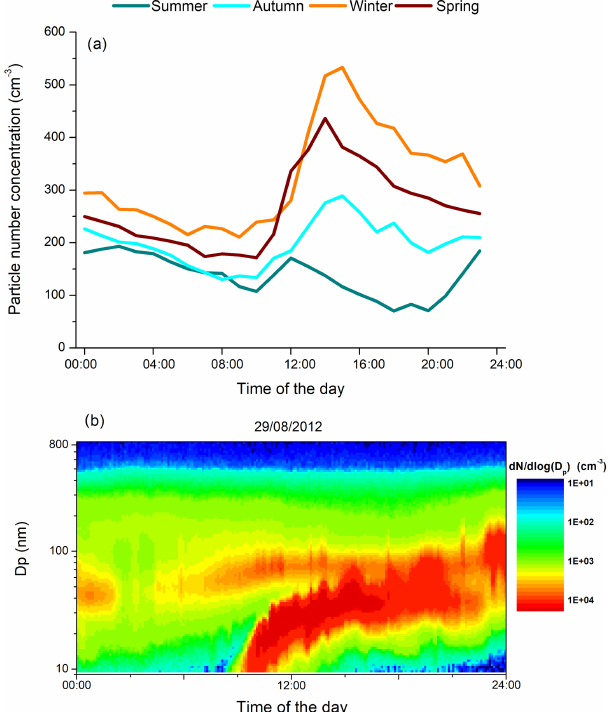
Figure 2. (a) Average diurnal variation in nucleation mode particle number concentration (hourly values) at Finokalia over the period June 2008–June 2018. (b) New particle formation event captured at Finokalia on 29 August 2012 (time in